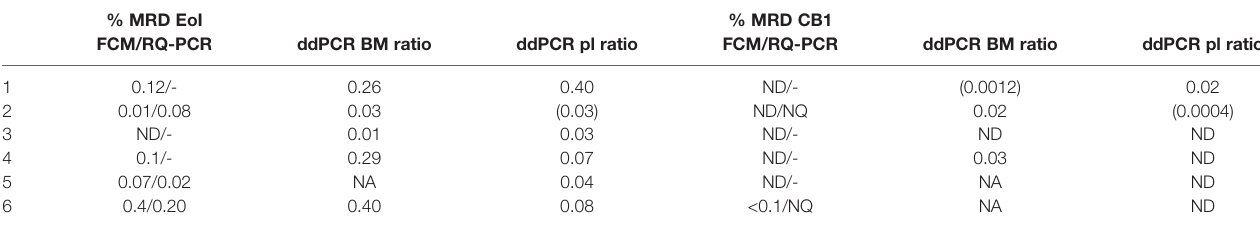
Parentheses denote trace amounts (1 – 2 positive droplets). For each patient, all ddPCR targets were analyzed in a multiplexed manner, and results re fl ect the combined signals from all targets. MRD, measurable residual disease; BM, bone marrow; pl, plasma; FCM, fl ow cytometry; EoI, end of induction; CB1, end of consolidation block 1; RQ-PCR, real-time quantitative